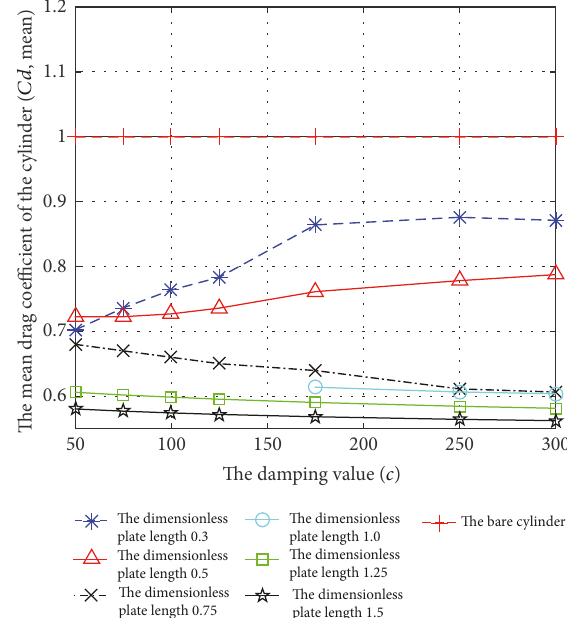
Figure 15: The variation of the mean drag coefficient with the changing of the damping value.